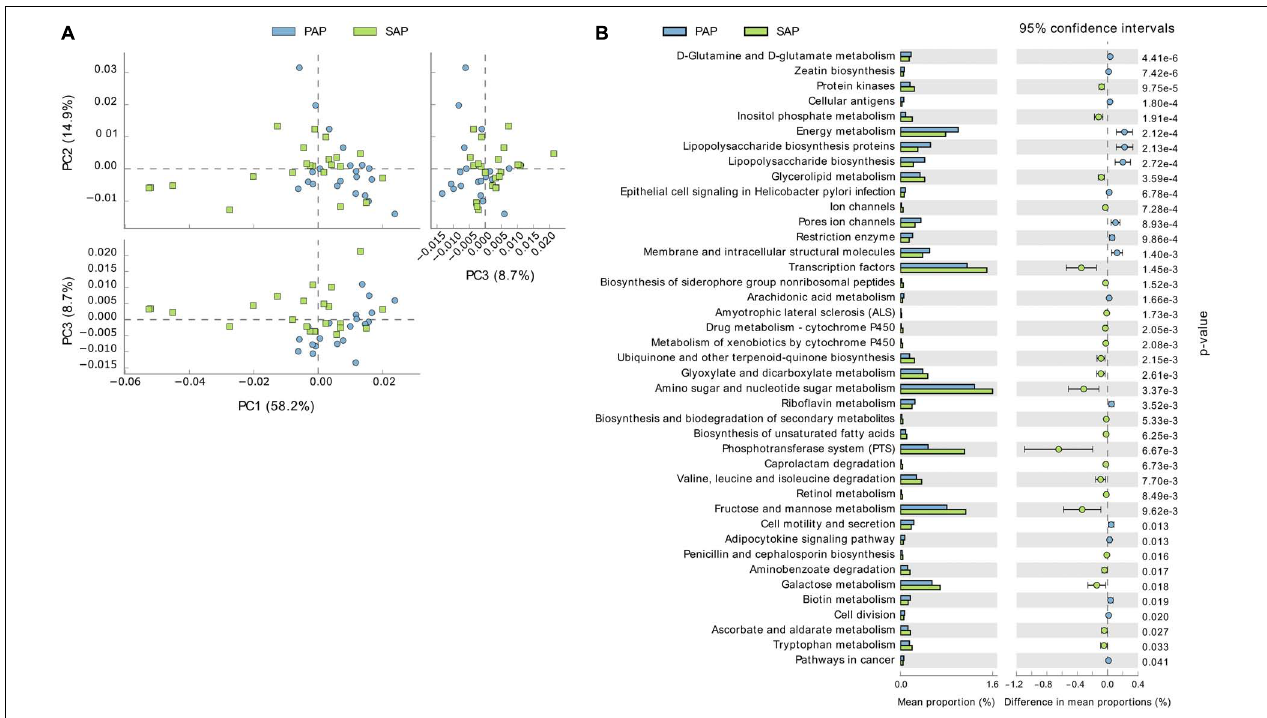
FIGURE 6 | Functional profiles of PAP and SAP-associated bacterial communities in root canal samples. The KEGG orthologs (predicted functions) inferred from the relative abundance of OTUs using PICRUSt were collapsed into level-3 KEGG ontology (KEGG pathways) and compared among PAP and SAP groups using STAMP. (A) Principal component analysis of KEGG pathways. (B) Significant differences ( P < 0.05, two-sided Welch t -test) between PAP and SAP functions. STAMP was set to consider pathways represented by at least 10 sequences and an effect size filter (ratio of proportion) of 1.2. PAP, primary apical periodontitis; SAP, secondary apical